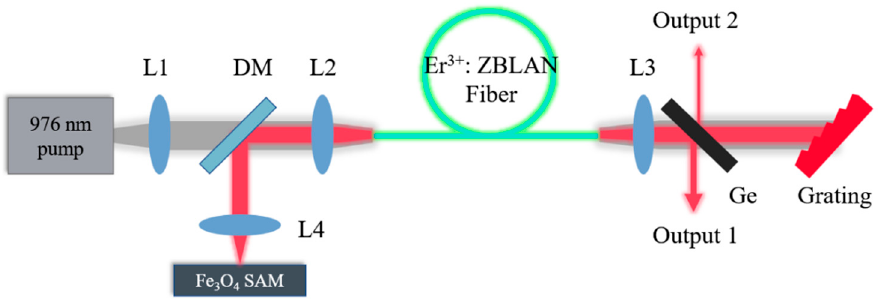
Figure 1. Experimental setup for Q-switched wavelength-tunable fiber laser. L1, aspheric lens; L2, L3, L4, plano-convex lenses; DM, dichroic mirror; Ge, germanium plate.